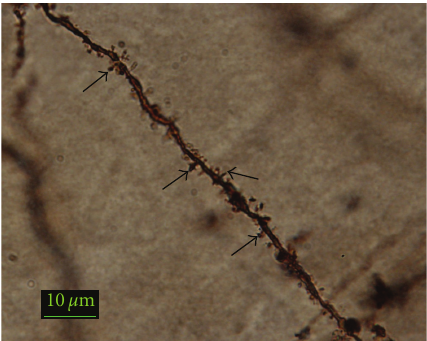
Figure 1: Photomicrograph (100x) of a secondary basal dendrite from a CA1 pyramidal cell taken under oil immersion from a young female. Arrows denote